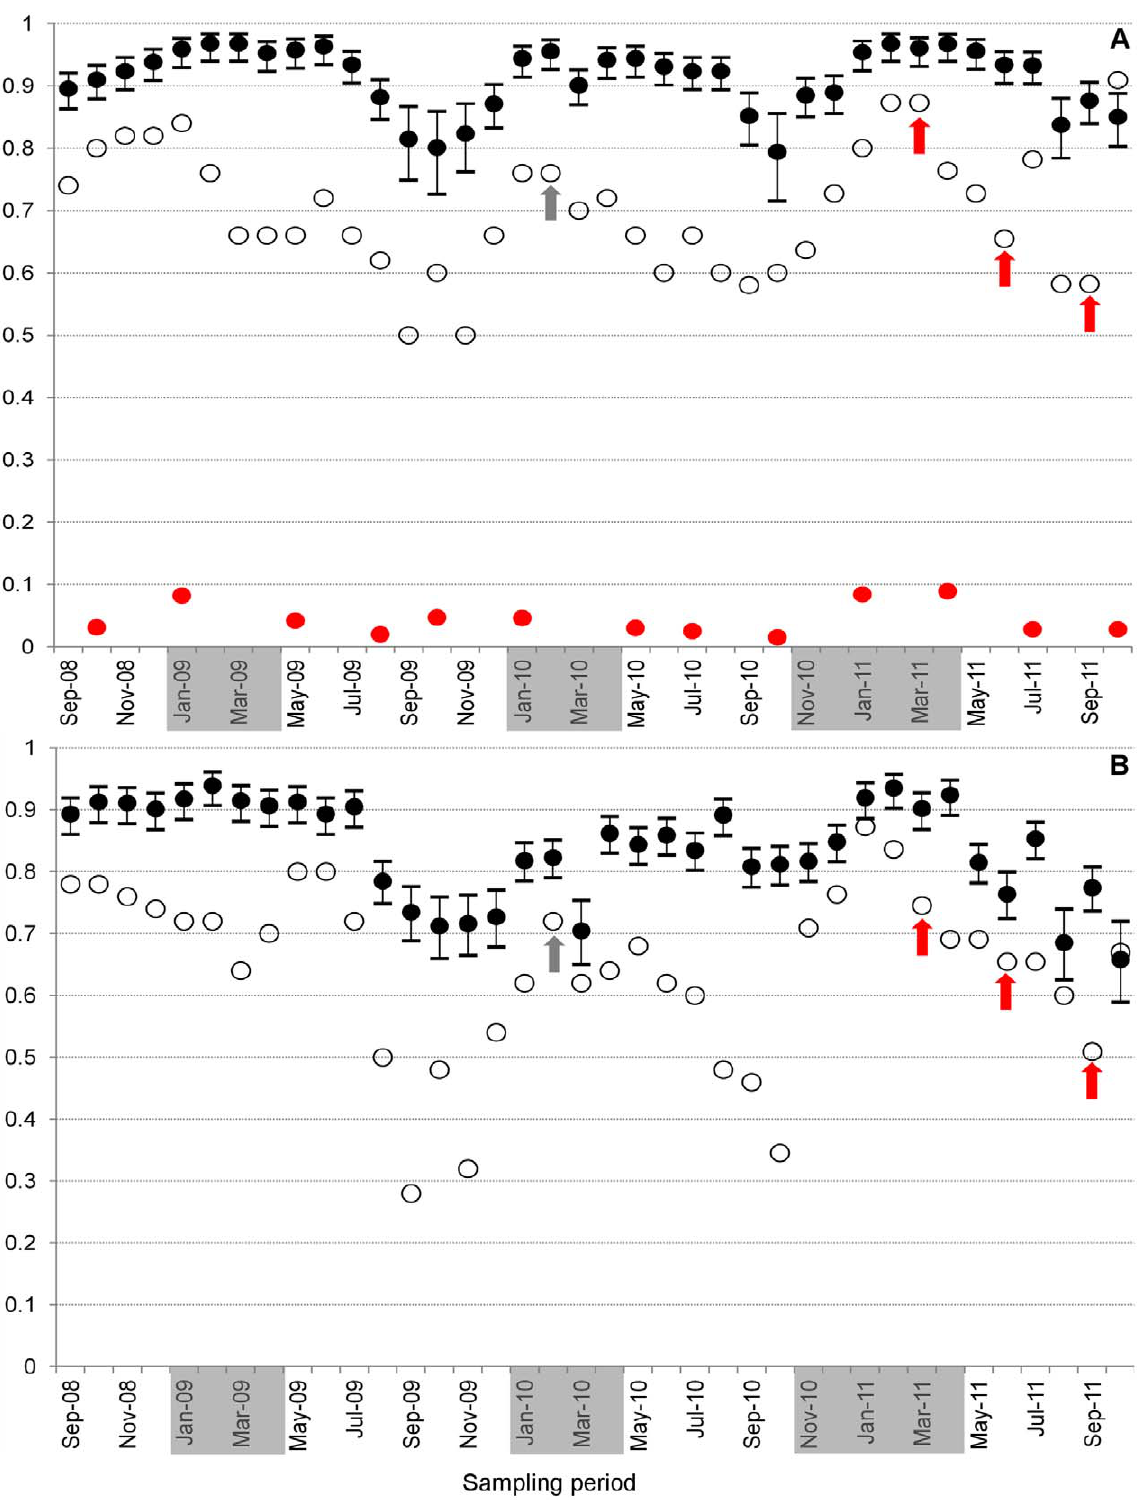
Figure 3. Observed and model-estimated dwelling infestation by Aedesaegypti (A) and Ae.albopictus (B). Monthly model-derived site- occupancy estimates (solid circles, with 95% confidence intervals); monthly observed infestation (empty circles); and Ae. aegypti infestation indices derived from 13 ‘rapid larval surveys’ [28] (red circles in panel A). On the x axis, grey boxes highlight the periods in which city-wide, massive Aedes control campaigns, called Operac¸a˜o Impacto [29,30], took place. Arrows indicate months in which control activities were performed in our study neighborhood (red arrows, interventions included as model covariates).